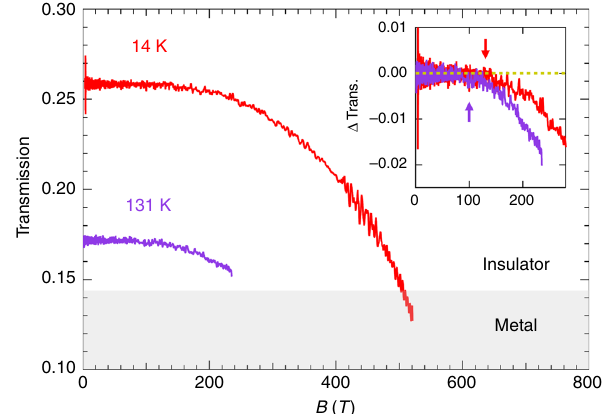
Fig. 4 Magnetic- fi eld dependence of the optical transmission at 14 and 131 K. The transmission is plotted before the breaking point of the destructive measurement. The shaded area indicates transmission lower than that in the high-temperature metallic phase at 291 K. Inset: transmission change Δ Trans. as a function of the magnetic fi eld. The dashed yellow line corresponds to Δ Trans. = 0. The red and purple arrows indicate the fi eld positions ( B * ) where Δ Trans. deviates from